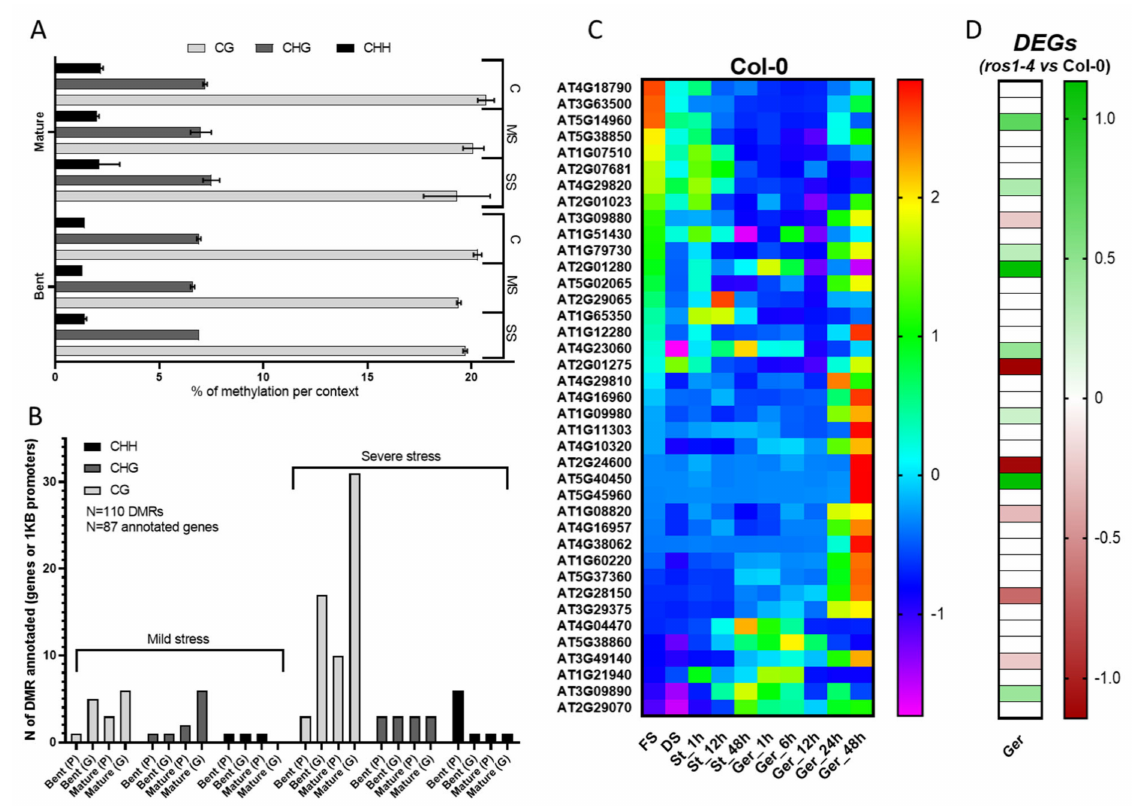
Figure 5. Methylome analysis and DMRs related to germination genes. ( A ) Percentage of cytosine methylation per context (CG, CHG, CHH) on bent and mature embryo stages of Col-0 seeds grown under the Control temperature (C = 23 ◦ C) or Mild Stress (MS = 25 ◦ C), or Severe Stress (SS = 27 ◦ C). ( B ) Amount of DMRs between control condition and MS or control condition and SS in all contexts (CH, CHG, CHH) for bent and mature stages at 1 Kb promoter regions (P) and gene sequences (G). ( C ) Normalized expression (TPM) heat-map of 39 genes differentially expressed during seed germination and containing a DMR at mature stage with severe heat stress (MethDEGs). Expression in Col-0 seeds at conditions: fresh seed (FS); dried seed (DS); stratified and imbibed seeds at 4 ◦ C (St) for 1 h, 12 h and 48 h; stratified and imbibed seeds at 20 ◦ C light for germination (Ger) for 1 h, 6 h, 12 h, 24 h, and 48 h. ( D ) Differential expression analysis of MethDEGs between ros1-4 and Col-0, comparing dry seeds against two germination stages (II and IV), whereas green indicates upregulated genes and red indicates downregulated genes in ros1-4